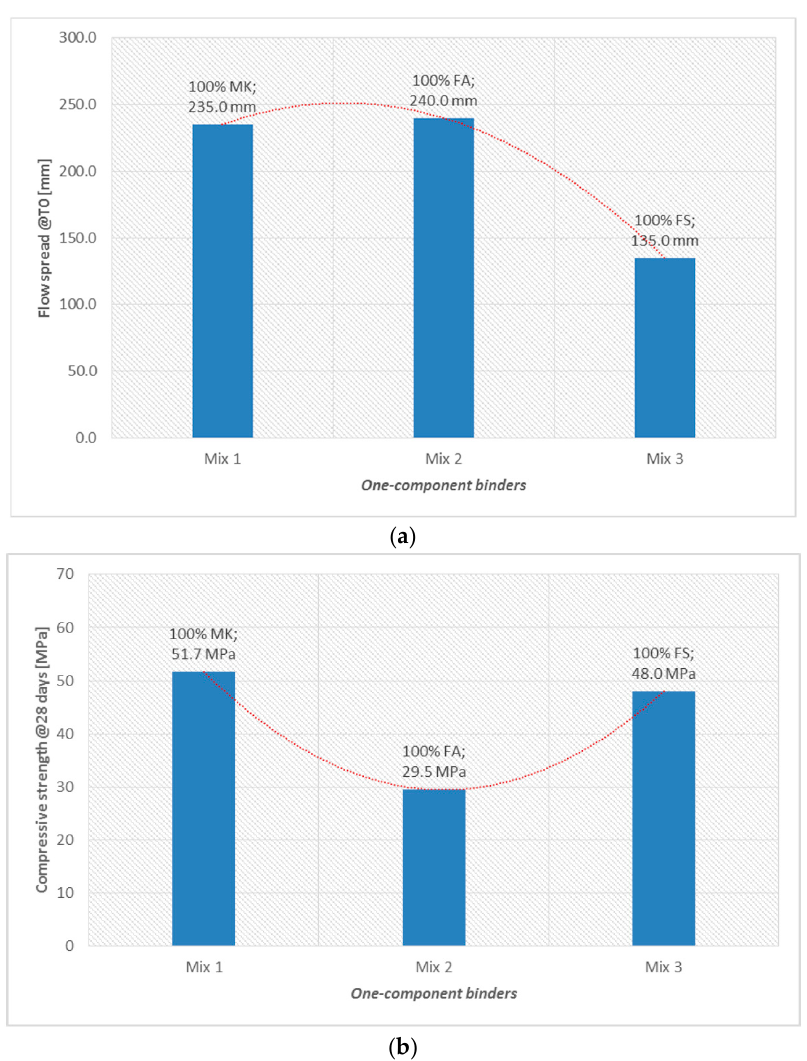
Figure 3. Technical performance comparison for mortars based on 100% metakaolin (Mix 1), 100% fly ash (Mix 2), and 100% furnace slag (Mix 3): ( a ) flow spread and ( b ) compressive strength at 28 days.